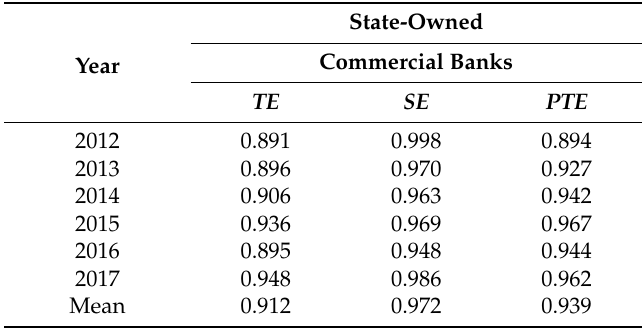
Table 8. The average efficiency of the state-owned commercial banks (2012–2017).